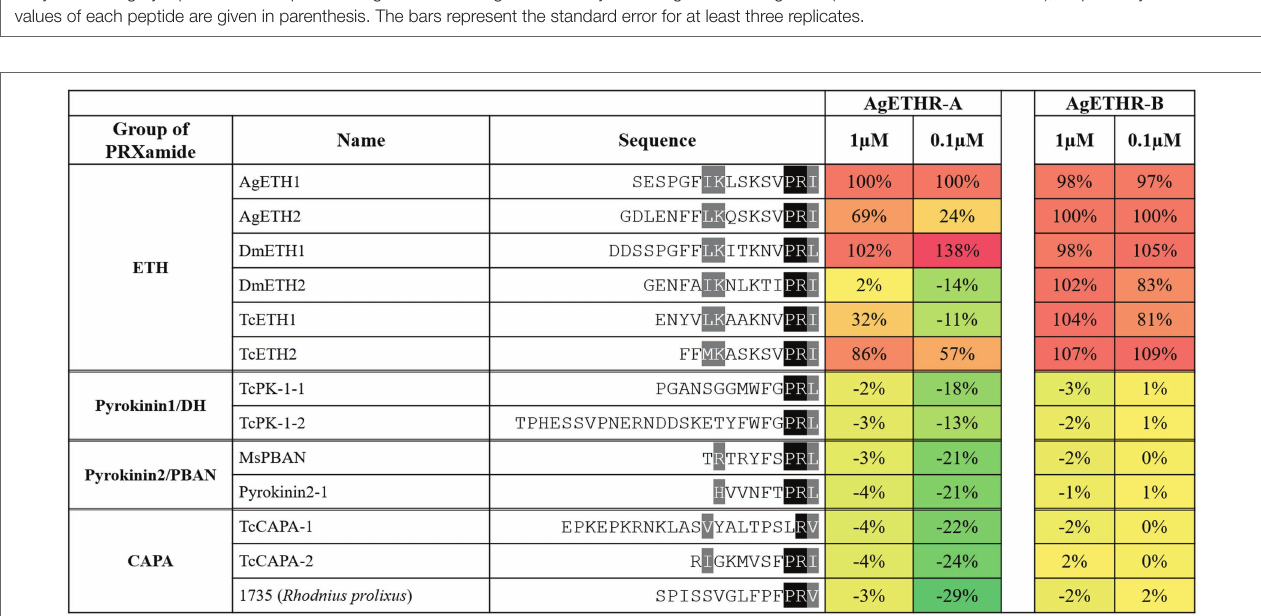
FIGURE 3 | Dose–response relationship to AgETH1 and AgETH2 peptides in heterologously expressed AgETHR-A (A) and AgETHR-B (B) CHO-WTA11 cell lines. Gray and dark gray represent the response of AgETHR-A and AgETHR-B to synthetic AgETH1 and AgETH2 (from 1 × 10 − 2 to 3 × 10 5 nm), respectively. EC50 values of each peptide are given in parenthesis. The bars represent the standard error for at least three replicates.